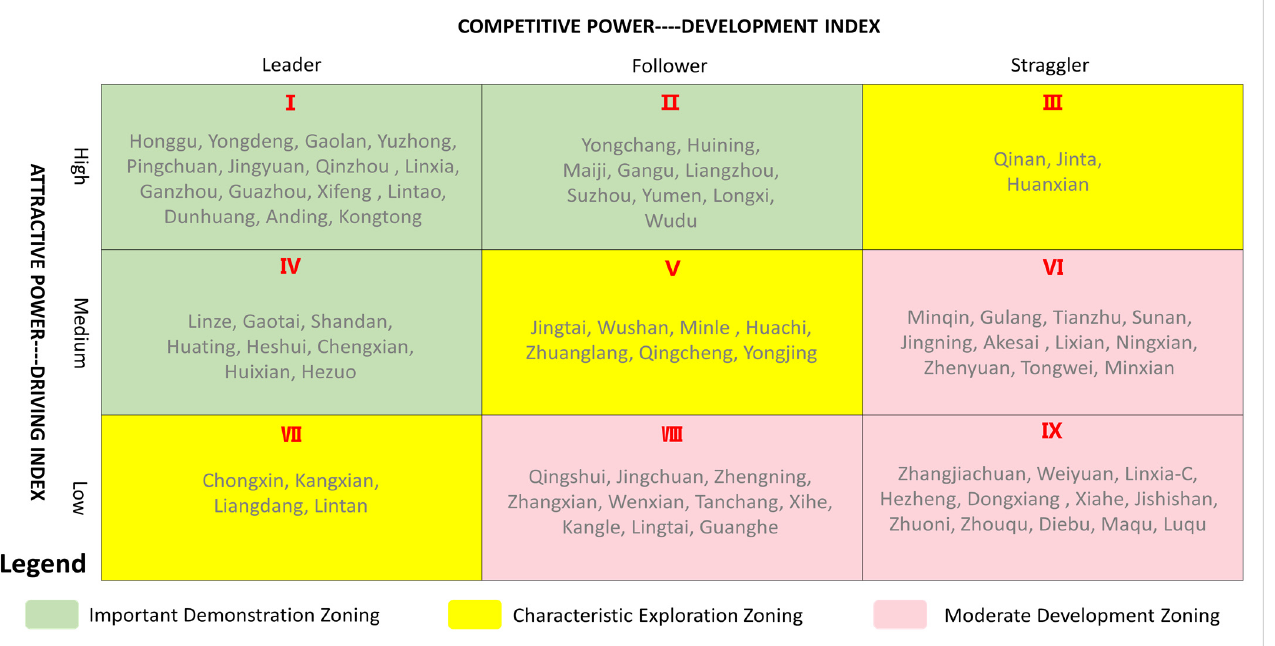
Land 2023 , 12 , 616 Figure 9. Analysis on spatial zoning of village facilities digitalization in Gansu.